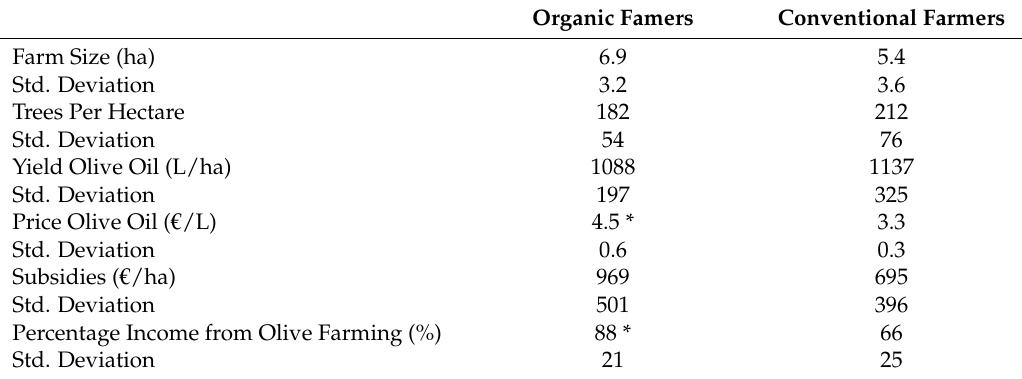
Table 1. Farming characteristics and olive oil yields among organic ( n = 16) and conventional ( n = 23) olive farmers in Messenia, Greece. The asterisks (*) mark statistically significant differences (<0.05) between the two groups of